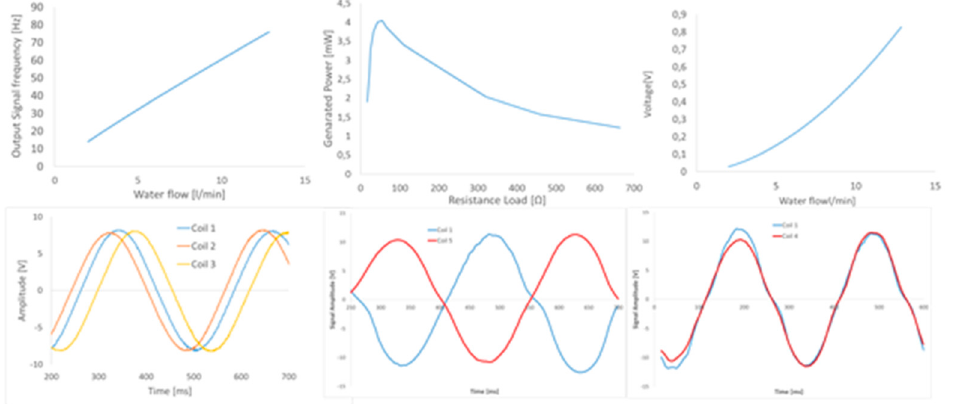
Figure 4. Electric characteristics of energy harvester: ( a ) frequency output signal as a function of water flow, ( b ) generated power function of loading resistance, ( c ) generated voltage function of water flow (RL = 55 Ω ), ( d ) output signal wave form for three inductors, ( e ) signal wave form for non in phase inductors, ( f ) signal wave form for in phase